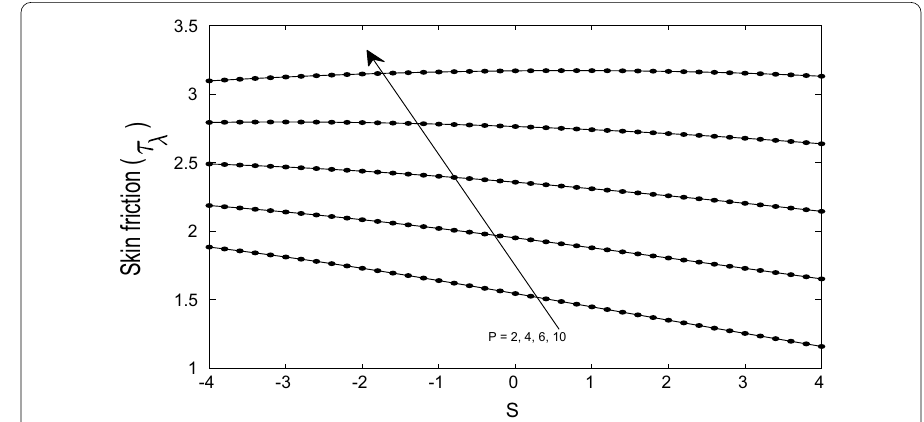
0.2, β 0.2, d 1.5, A ∗ 1, w 0.8 ) = = − = = =